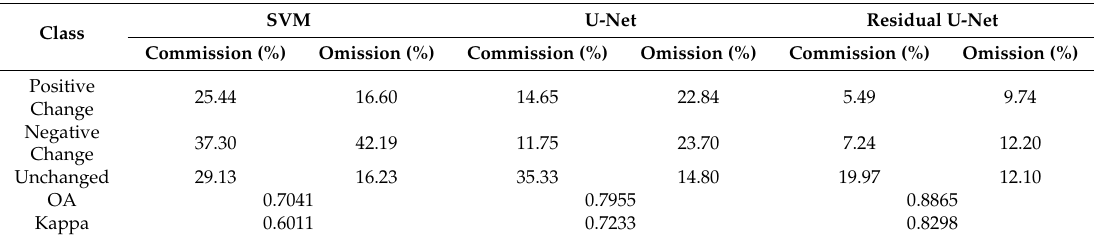
Table 5. Accuracy assessment of the urban building change detection